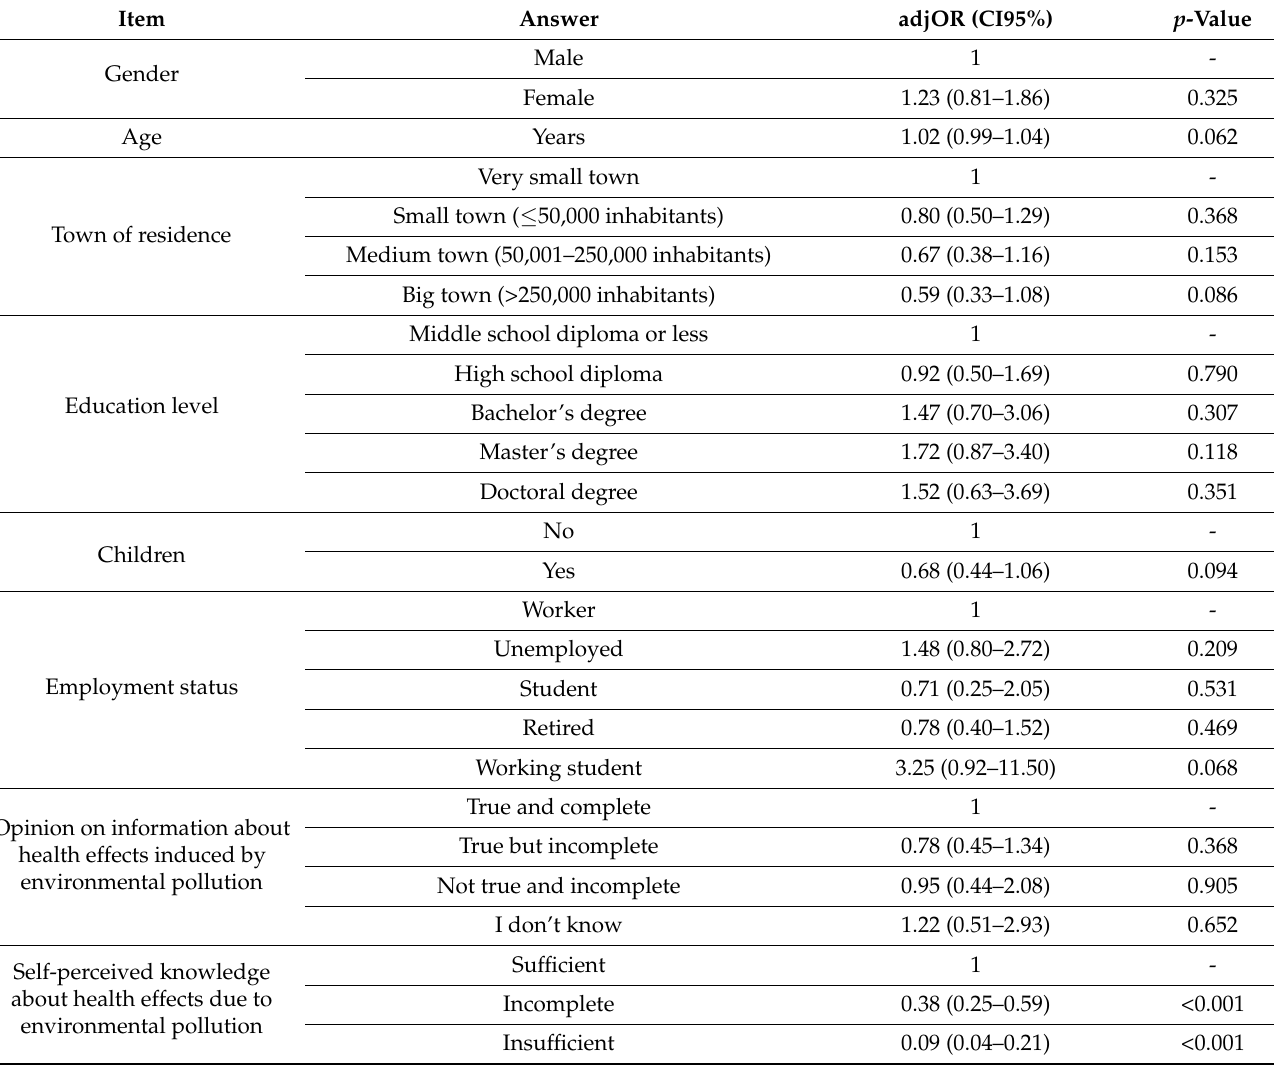
Table 1. Multivariable logistic regression model on the first outcome: verifying information about the health effects of